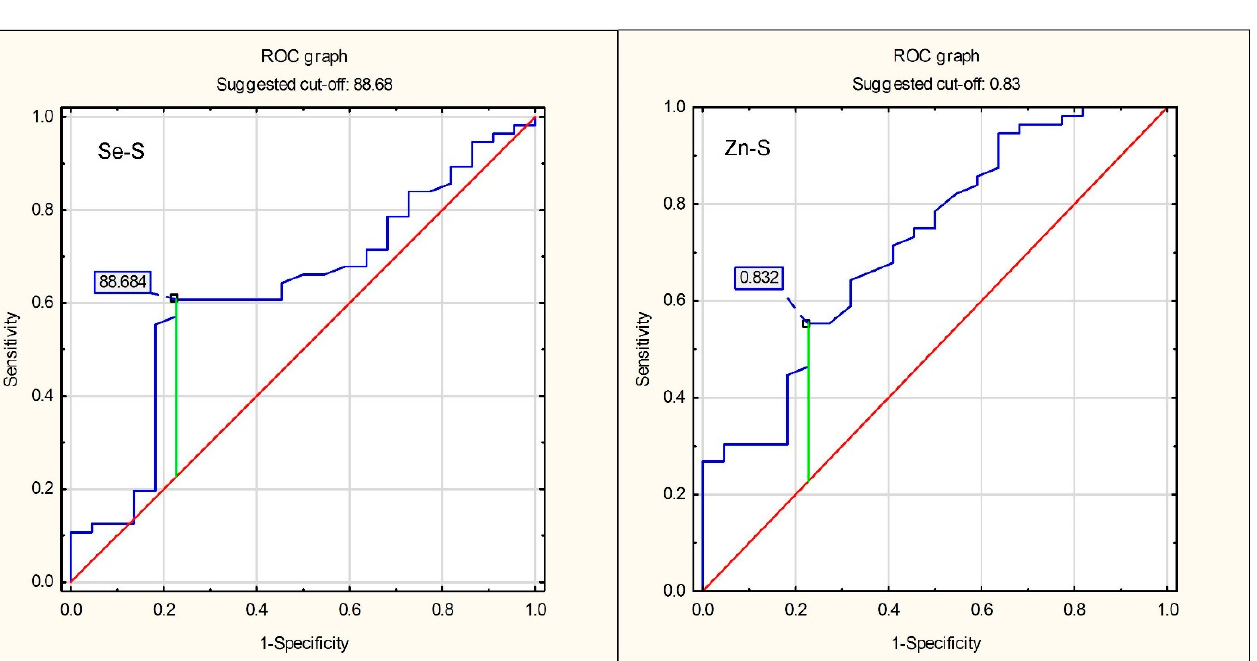
Table 5. Results of logistic regression analysis in the study group.